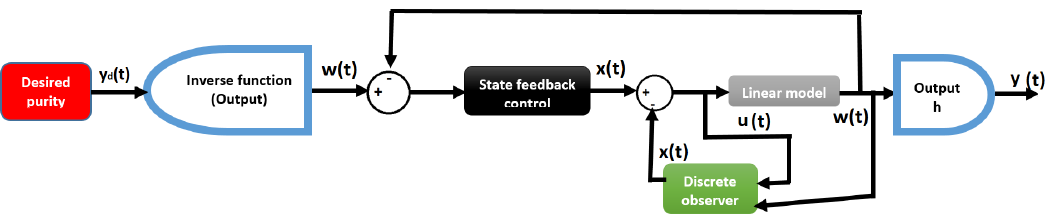
Figure 12. Implementation of state feedback control on the Hammerstein–Wiener